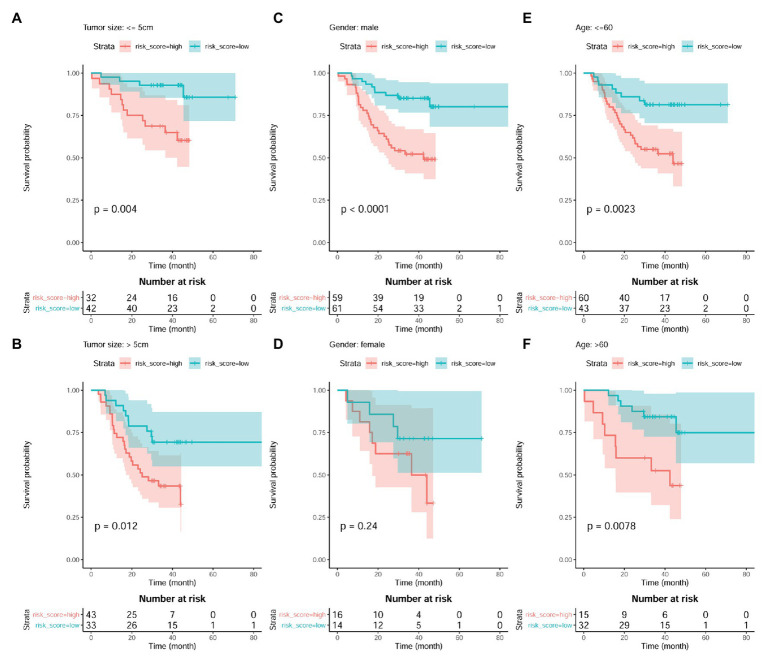
Prognostic effects of risk score in HCC patient of different gender, age, and tumor size groups. (A,B) Kaplan-Meier survival analysis of risk score in HCC patients with small tumors (tumor size ≤5 cm) group and large tumors (tumor size > 5 cm), respectively. (C,D) Kaplan-Meier survival analysis of risk score in male HCC patients and female ones, respectively. (E,F) Kaplan-Meier survival analysis of risk score in young HCC patients (≤60 years) and old ones (>60 years), respectively. Kaplan-Meier survival analysis with log-rank test was used, and p < 0.05 was considered as significant.